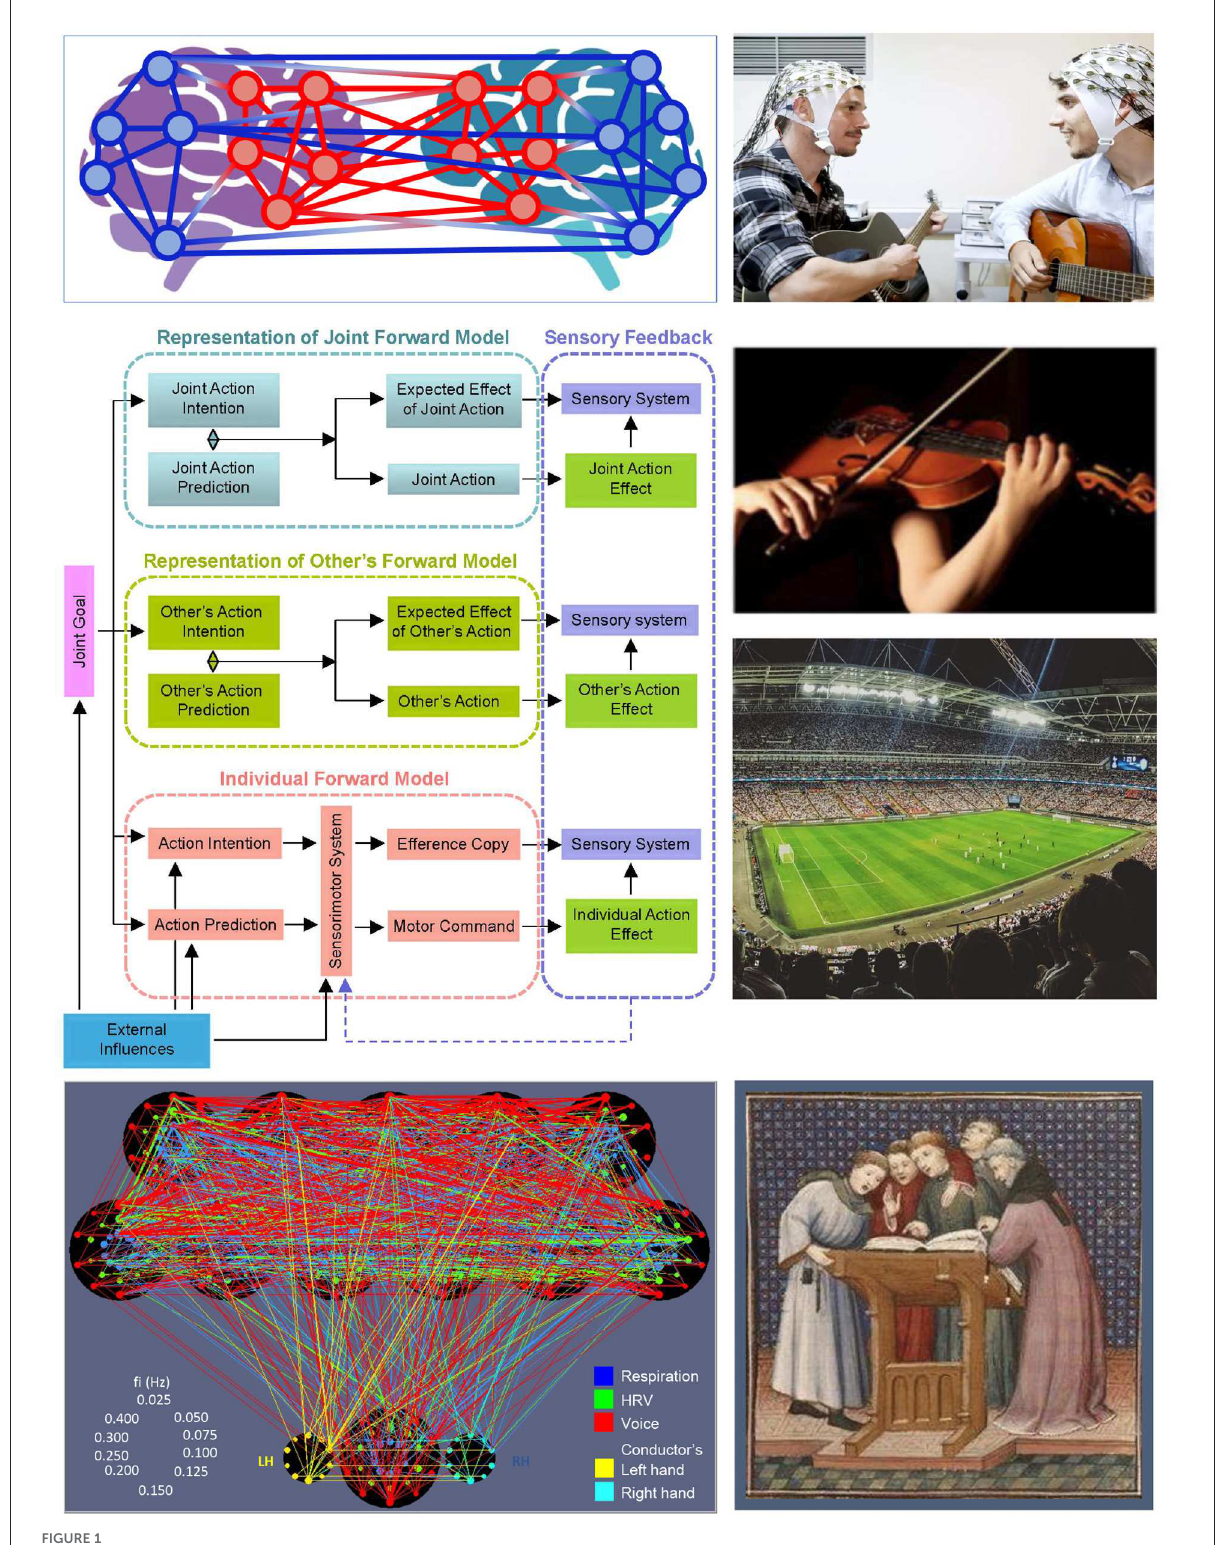
FIGURE1 Joint forward model for interpersonal action coordination and various social interaction situations described in the Research Topic. The joint forward model for interpersonal action coordination with three representation levels (i.e., representation of individual, other’s, and joint forward models with corresponding sensorimotor feedbacks) is represented in the middle left (adapted from Müller et al., 2021). This model reflects